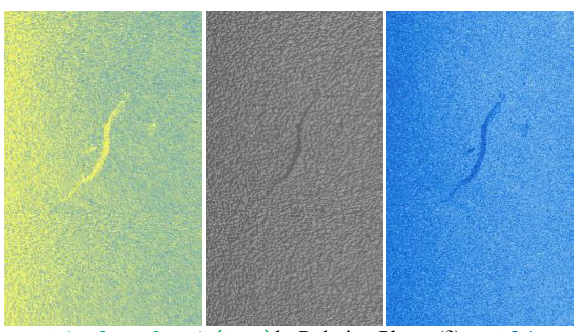
Figure 2: Plots showing the various hybrid pol oil-slick features considered in this study